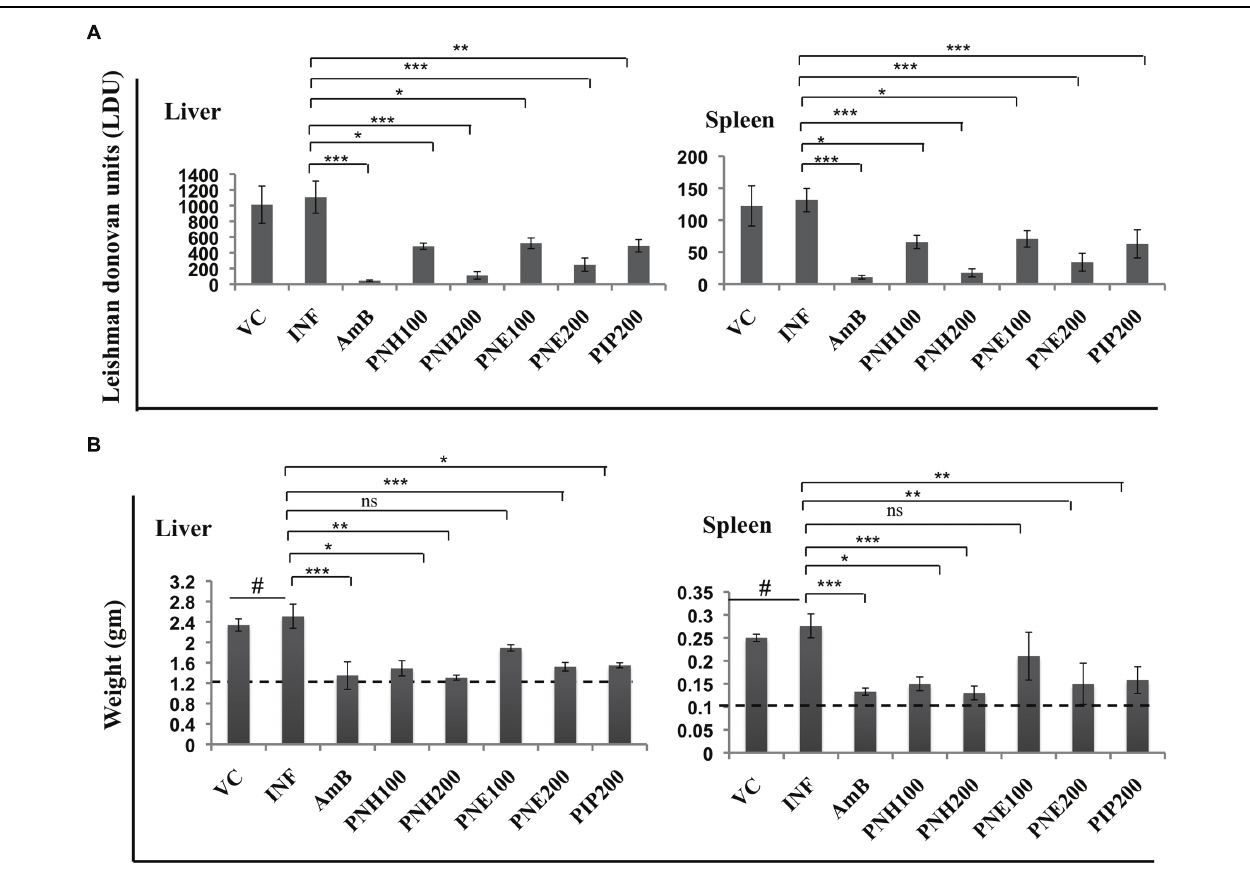
FIGURE 4 | In vivo therapeutic potential of P. nigrum bioactive fractions. (A) Estimation of parasite burden in untreated and bioactive fractions treated mice. VC = vehicle control (0.5% DMSO in PBS), INF = Infection control, AmB = AmB at 5 mg/kg bw, PNH100 = P. nigrum hexane fraction at 100 mg/kg bw, PNH200 = P. nigrum hexane fraction at 200 mg/kg bw, PNE100 = P. nigrum ethanolic fraction at 100 mg/kg bw, PNE200 = P. nigrum ethanolic fraction at 200 mg/kg bw and PIP200 = Piperine at 200 mg/kg bw. L. donovani infected BALB/c mice were either untreated or subjected to different treatments followed by estimation of hepatic and splenic parasite burden as described in methods. ∗∗∗ P < 0.001, ∗∗ P < 0.01, and ∗ P < 0.05 in relation to INF group. (B) Differences in liver and spleen weights amongst various experimental groups. The dotted line represents average weight of respective organs in normal mice. # P < 0.001 in comparison to naive mice, for rest ∗∗∗ P < 0.001, ∗∗ P < 0.01, ∗ P < 0.05, and ns = non-significant with respect to